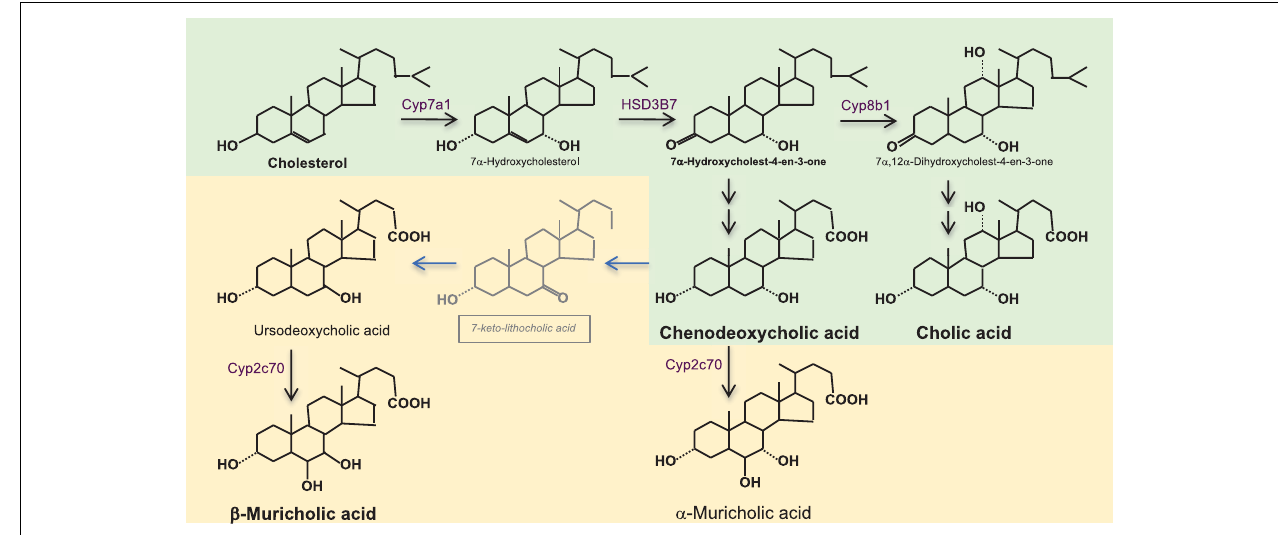
FIGURE 1 | Bile acid synthesis in the liver. Bile acids (BAs) synthesis from cholesterol synthesis requires almost 20 enzymatic reactions in different subcellular compartments of the hepatocyte. The rate limiting enzyme is cholesterol 7 α -hydroxylase (CYP7A1). Its activity is reflected by serum 7 α -hydroxy-4-cholesten-3-one (C4) which is formed by the action of 3 β -hydroxy- (cid:49) 5 -C 27 -steroiddehydrogenase/isomerase (HSD3B7). In humans (shown in green), the primary BAs are chenodeoxycholic acid (CDCA) and cholic acid (CA); the ratio between them is determined by 12 α -hydroxylase (CYP8B1), which is required for the formation of CA. In rodents (shown in yellow), there are additional primary BAs; ursodeoxycholic acid (UDCA) and α -and β -muricholic acids ( α / β MCA). α / β MCAs are generated by 7 β -hydroxylation of CDCA and UDCA by cytochrome CYP2C70 while the mechanism of epimerization of CDCA toward UDCA still is unknown. BAs are conjugated with glycine- or taurine (in humans) and with taurine (in rodents) before excretion into bile. Murine BA profiles are much more hydrophilic than human BA profiles and have substantially different activation proprieties of the nuclear BA receptor farnesoid X receptor (FXR, see Figure 2 ). While CDCA is the strongest natural activator of FXR, taurine-conjugated α / β MCAs are natural antagonists of FXR, which one needs to keep in mind when translating BA-related metabolic data from rodents to